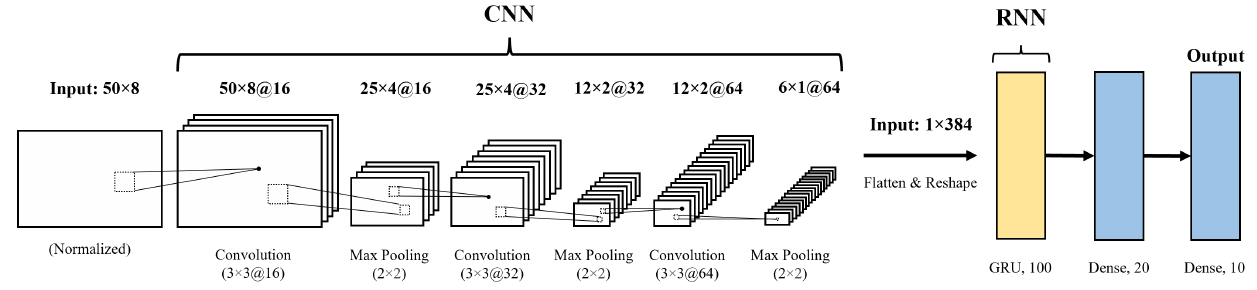
Figure 8. Proposed CRNN architecture consisting of three convolutional layers, GRU layers, and two dense